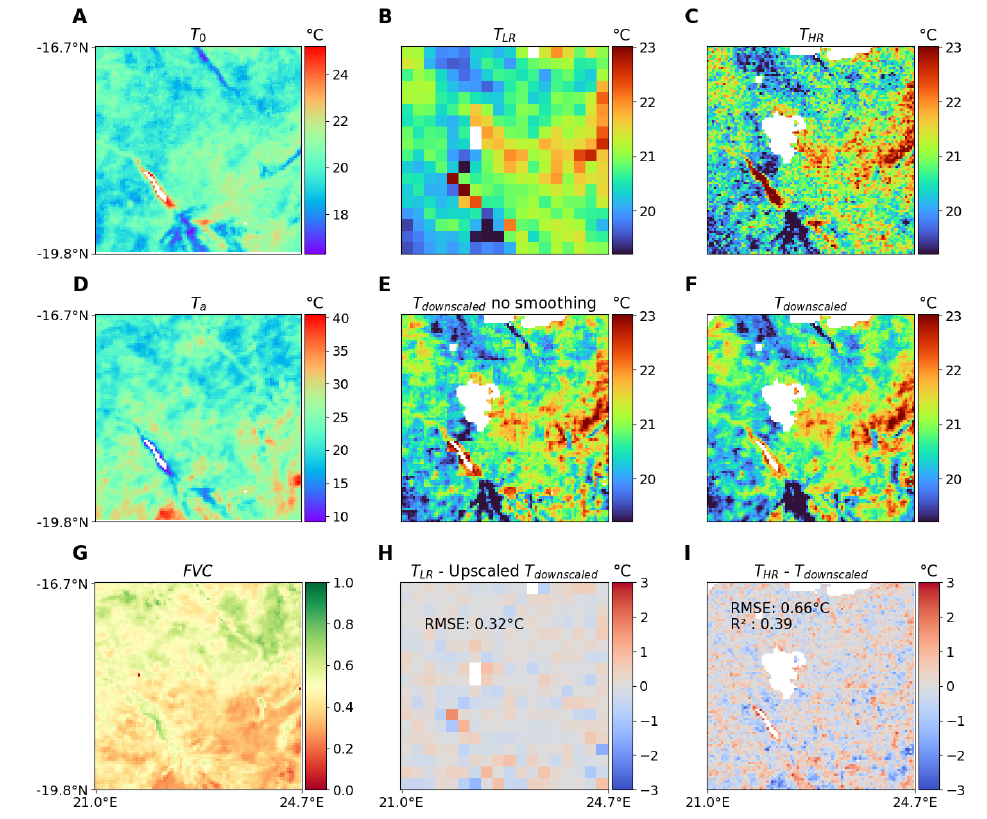
Figure 7. Different steps of the methodology applied to a scene from 11 February 2016 at 05:00 over the Okavango Delta (16.7 ◦ S 21.0 ◦ E to 19.8 ◦ S 24.7 ◦ E). Input ancillary variables ( T 0 , T a , FVC ) are in the ( A , D , G ) panels. T at low resolution and original high resolution in the panels ( B , C ). The T obtained by the downscaling method, before and after smoothing in the second row ( E , F ). The ( H ) panel contains the difference between the input T and 5 × 5 average T downscaled at low resolution with the RMSD overlaid over the scene. Finally, the bottom-right panel ( I ) shows the difference between the original high resolution and the T downscaled produced by the methodology. The RMSD and the coefficient of determination (R 2 ) are overlaid on the